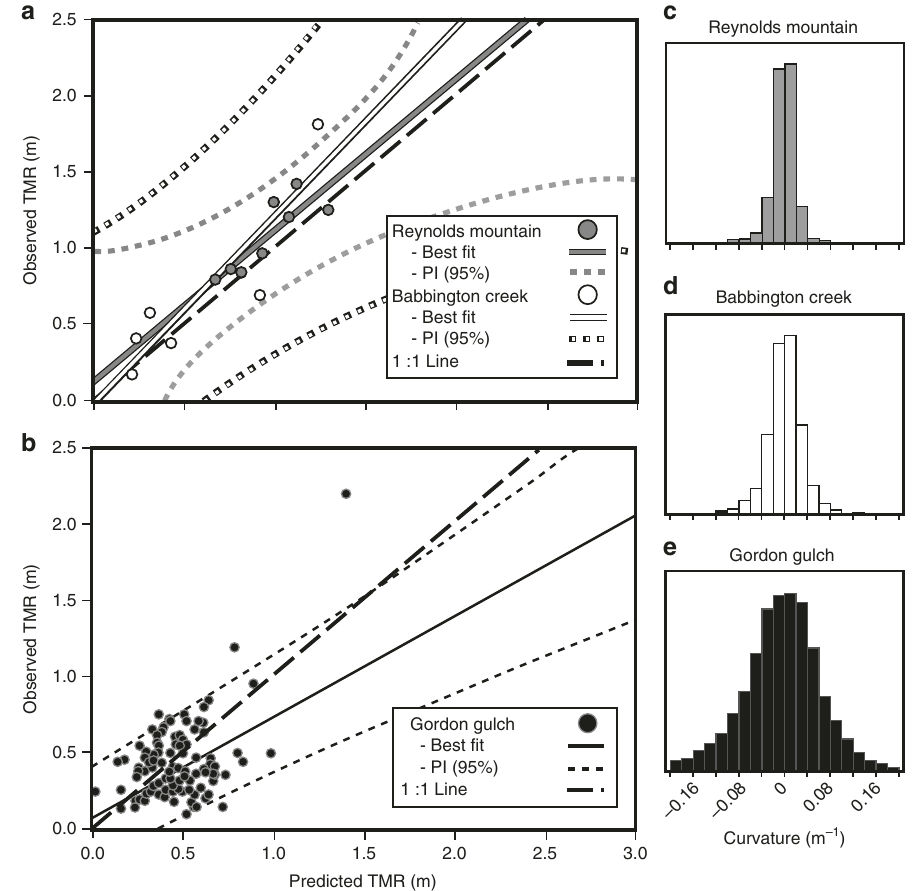
Fig. 3 Model validation. Validation of the thickness of the mobile regolith (TMR)-curvature ( C ) approach at Babbington Creek and Reynolds Mountain, Idaho ( a ) and Gordon Gulch, Colorado, USA ( b ). Solid white, gray, and black lines represent best- fi t predicted vs. observed TMR values based on curvature calculated from a Light Detection and Ranging (LiDAR)-derived digital elevation model (DEM) and a single soil pit for Reynolds Mountain ( c ), Babbington Creek ( d ), and Gordon Gulch ( e ), respectively. Large dashed black lines represents the 1:1 predicted versus observed line. The best- fi t slopes were not signi fi cantly different from one for Babbington Creek (|t| = 0.74 < critical t 0.05,5 = 2.571) and Reynolds Mountain (|t| = 0.01 < critical t 0.05,7 = 2.365), indicating unbiased models, whereas the slope was signi fi cantly lower than one for Gordon ( p < 0.001, |t| = 3.64 < critical t 0.05,162 = 1.974), indicating over- prediction with higher TMR than observed. Small white, gray, and black dotted lines represent the 95% prediction intervals